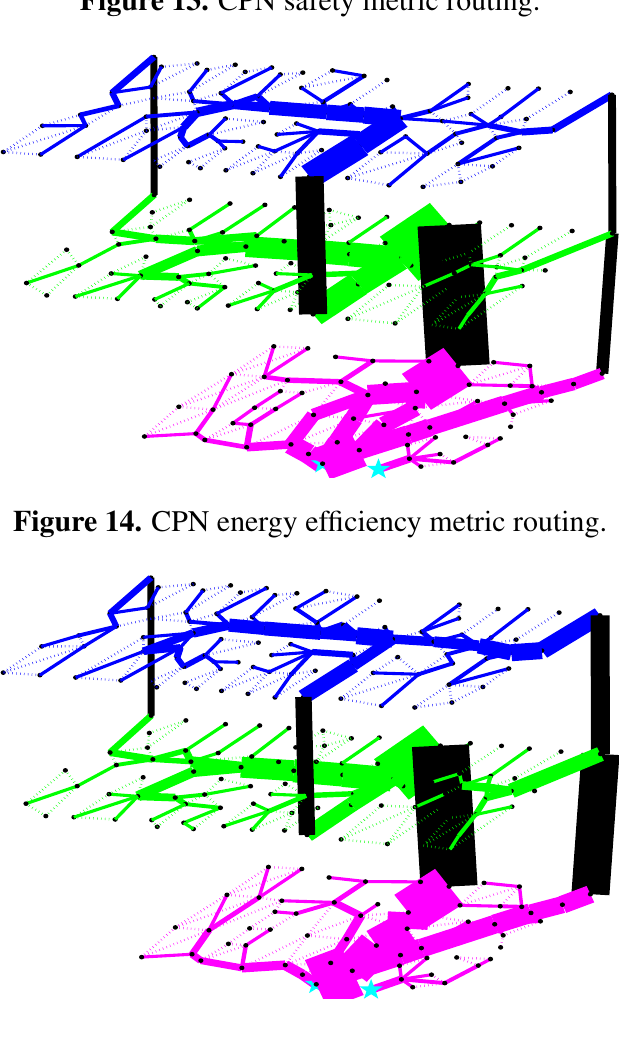
Figure 13. CPN safety metric routing.